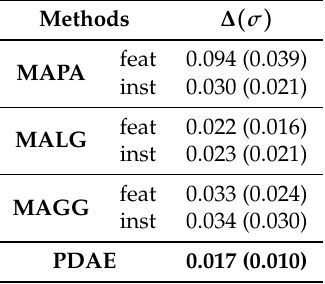
Table 1. The table shows ∆ of the alignment of Models 1 and 21 for all methods that were tested and visualised in Figure 3. The standard deviation σ is provided in parenthesis. PDAE performed the